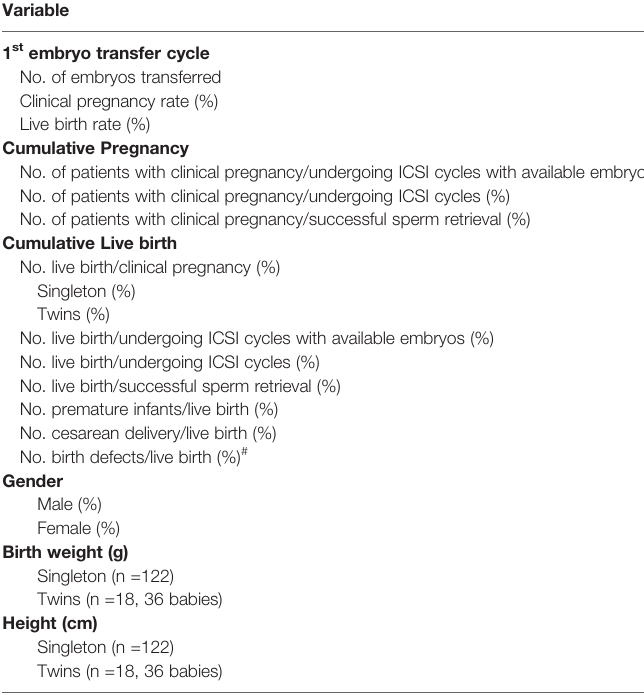
TABLE 2 | Embryo transfer and live birth outcomes. Variable NOA